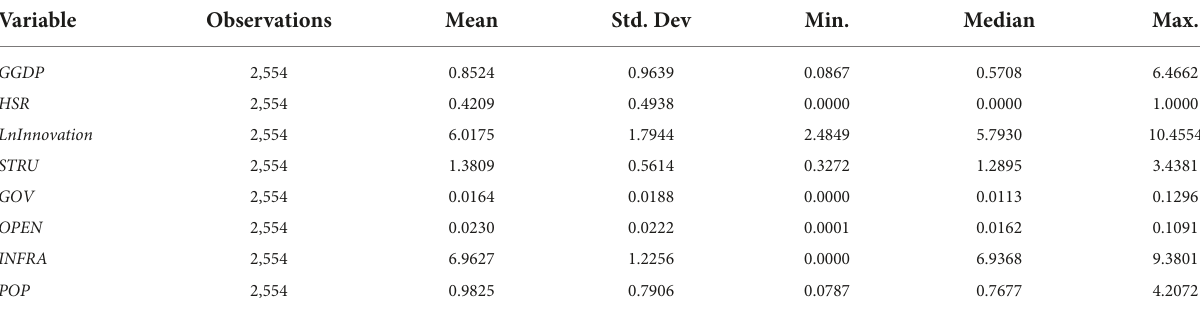
TABLE 2 The results of descriptive